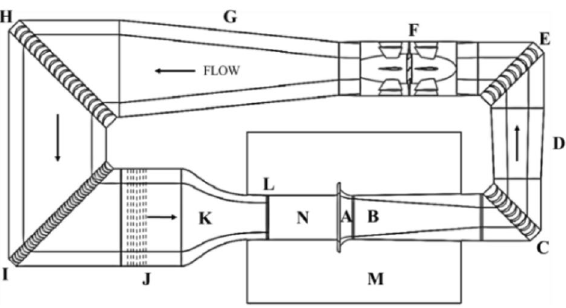
Figure 1. Top view of the wind tunnel in Jilin University general layout. The arrows indicate the direction of local flow. The key components are as follows: (A) Collector, (B) First diffuser, (C) First turning corner, (D) Second diffuser, (E) Second turning corner, (F) Axial fan, (G) Third diffuser, (H) Third turning corner, (I) Fourth turning corner, (J) Settling chamber, (K) Contraction, (L) Nozzle, (N) Test section, (M) Plenum chamber.